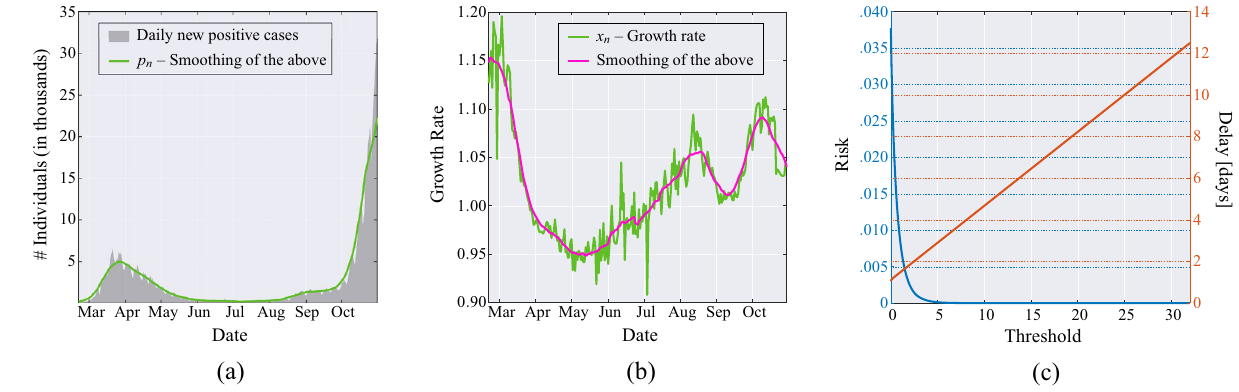
Figure 2. ( a ) Daily new positive individuals in Italy since February 21, 2020, and its moving average obtained with a window of 21 days (green line). ( b ) Growth rate of the epidemic computed from the averaged daily new positive cases (green line), and its time-varying mean obtained through a moving average that uses a window of 21 days (magenta line). ( c ) MAST performance, in terms of risk (left axis) versus threshold and mean delay (right axis) versus threshold, obtained from the Italian data for the COVID-19